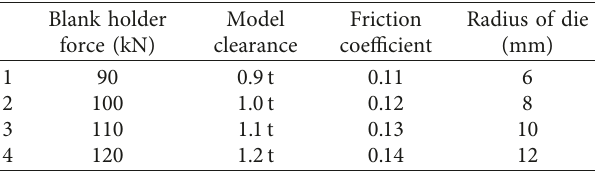
For convenience, use A, B, C, and D to represent blank holder force, die clearance, friction coefficient, and fillet radius of die, respectively.